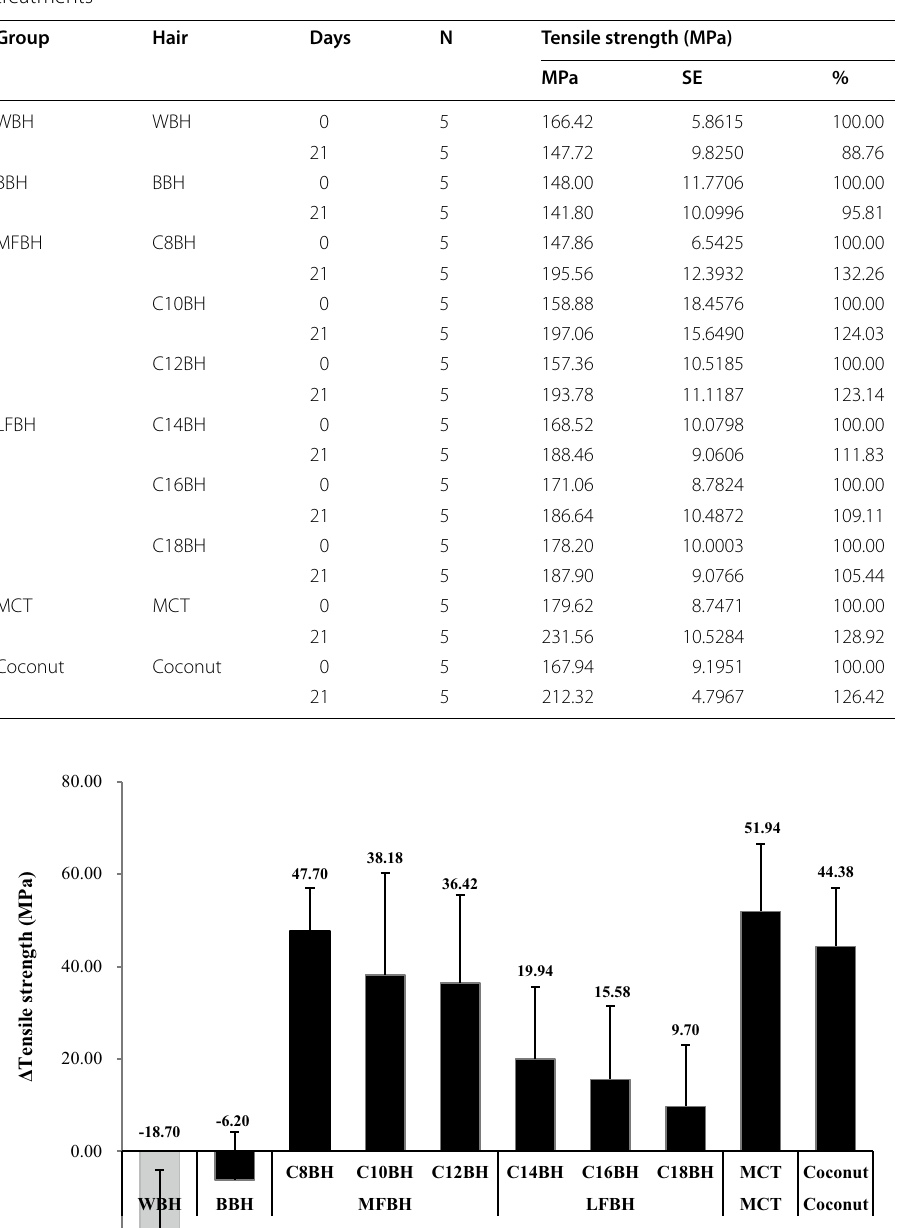
(105.44–111.83%). The order of percent increase was by C18BH < C16BH < C14BH <